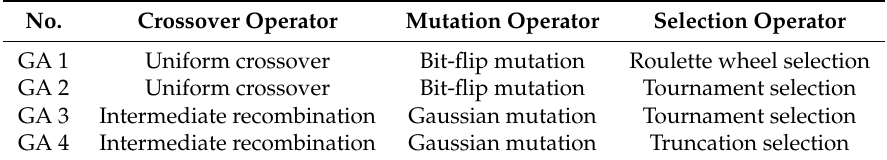
Table 2. Operator combinations of parallel genetic